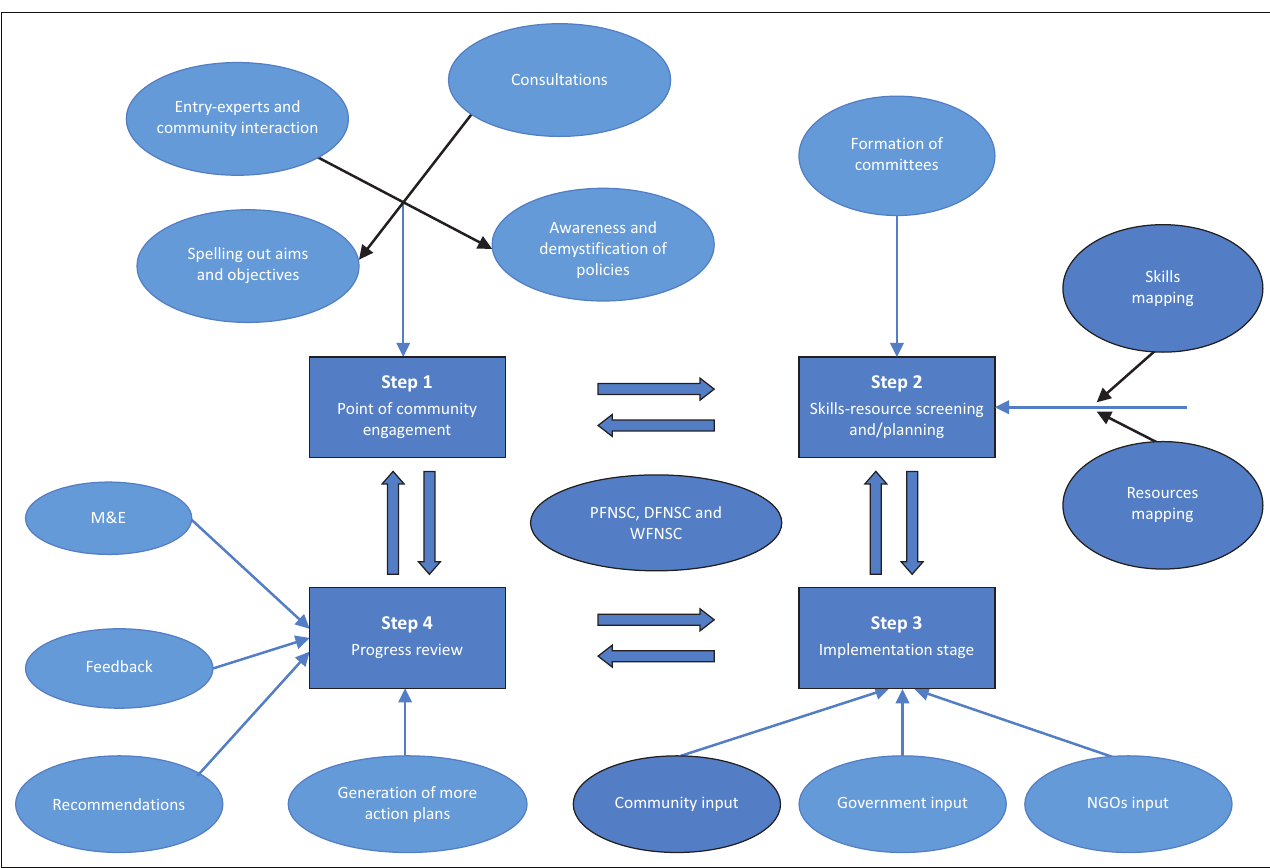
FIGURE 1 : Proposed food security implementation model for Matabeleland South